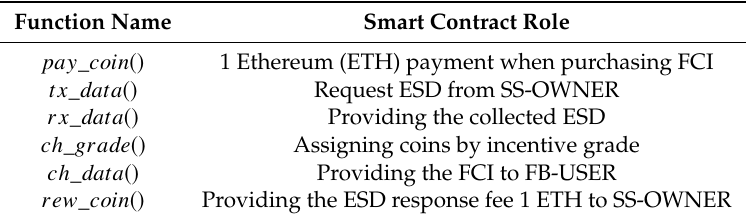
Figure 5. The experimental environment for operating blockchain-based transactions on BAFCS. Table 1. Function types and functions of a smart contract.